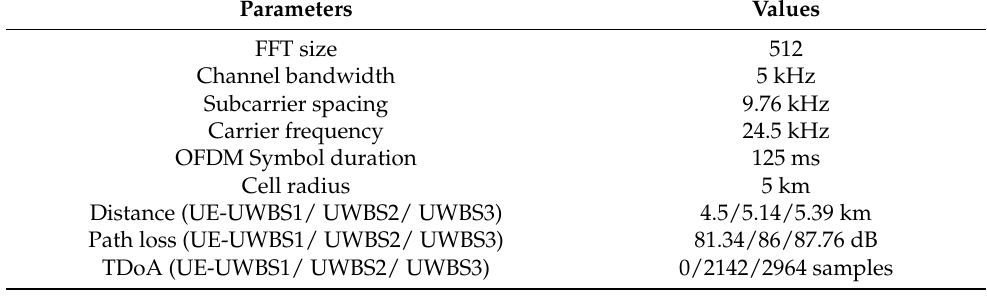
Table 2. Simulation parameters.